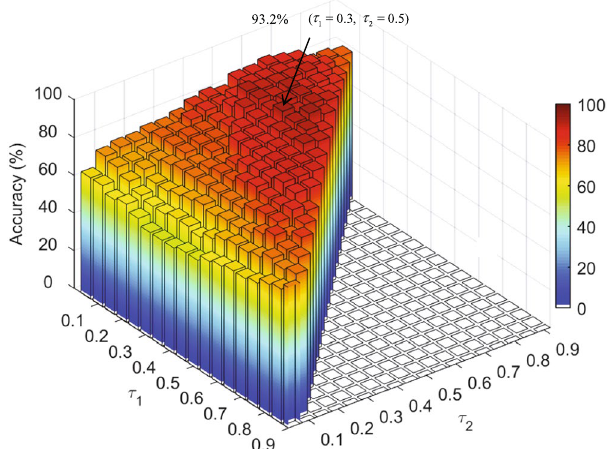
Figure 1. Classification accuracy of the hybrid high-order FC networks by integrating DN L , DN H and DN A (DN L + DN H + DN A ) with different kernel weighting factors τ 1 and τ 2 for DN L and DN H , respectively (the weight factors for DN A are determined by τ τ τ = − + 1 ( ) ). The best accuracy was achieved with τ = . 0 3 3 1 2 τ = . 0 5 , which is 93.2% as indicated by an arrow. 2